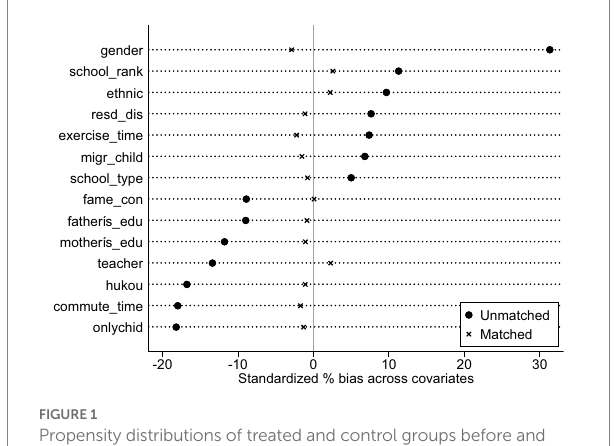
FIGURE 1 Propensity distributions of treated and control groups before and after matching.